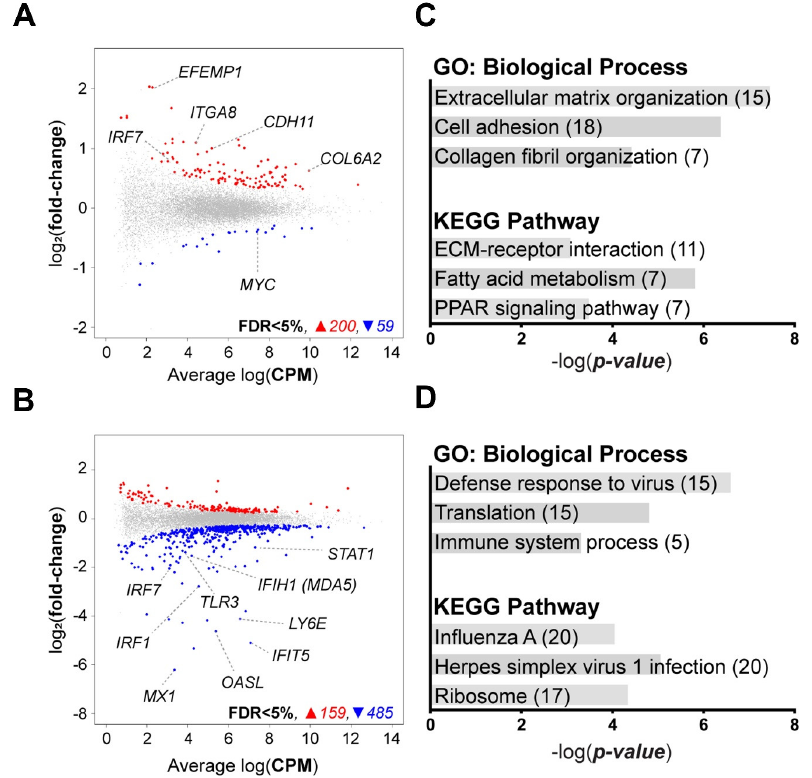
Figure 5. Transcriptomic profiles in the IRF7 -regulated DF-1 cell lines. Volcano plots of the transcriptomic differences between IRF7 -upregulated DF-1 cells (VPR) and mock controls ( A ), and between IRF7 -downregulated DF-1 cells (KRAB) and mock controls ( B ). The colored dots correspond to significant differentially expressed genes (DEGs; False discovery rate (FDR) < 5%). The numbers of DEGs are shown in the bottom right corner of each plot. Gene ontology (GO) and pathway analysis by DAVID using DEGs from the IRF7 -upregulated ( C ) or -downregulated DF-1 cells ( D ). The number of genes enriched in each biological process is in